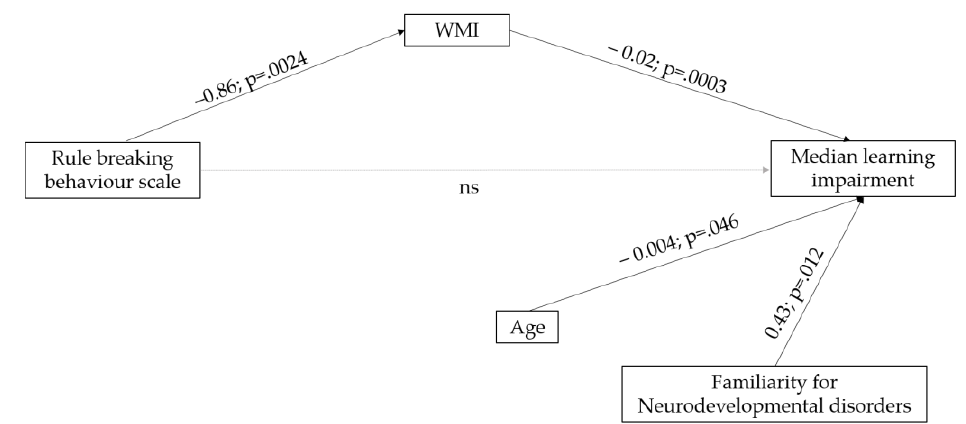
Figure 4. A mediation model analysis on the relationship between background, cognitive, and CBCL variables on median learning impairment (Indirect effect: BootLLCI = 0.0057; BootULCI = 0.03306).